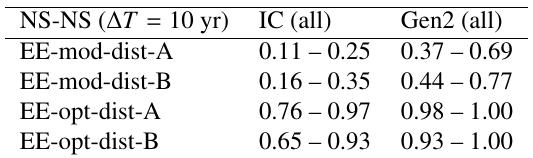
Table 3. The detection probabilities within a given time interval ∆ T = 10 years. The parameters used are ( Γ = (30, 2), (30, 0 , σ Γ ) 4), (10, 2), and (10, 4) for EE-mod-dist-A, EE-mod-dist-B, EE-opt-dist-A, EE-opt-dist-B, respectively. This table is adapted from